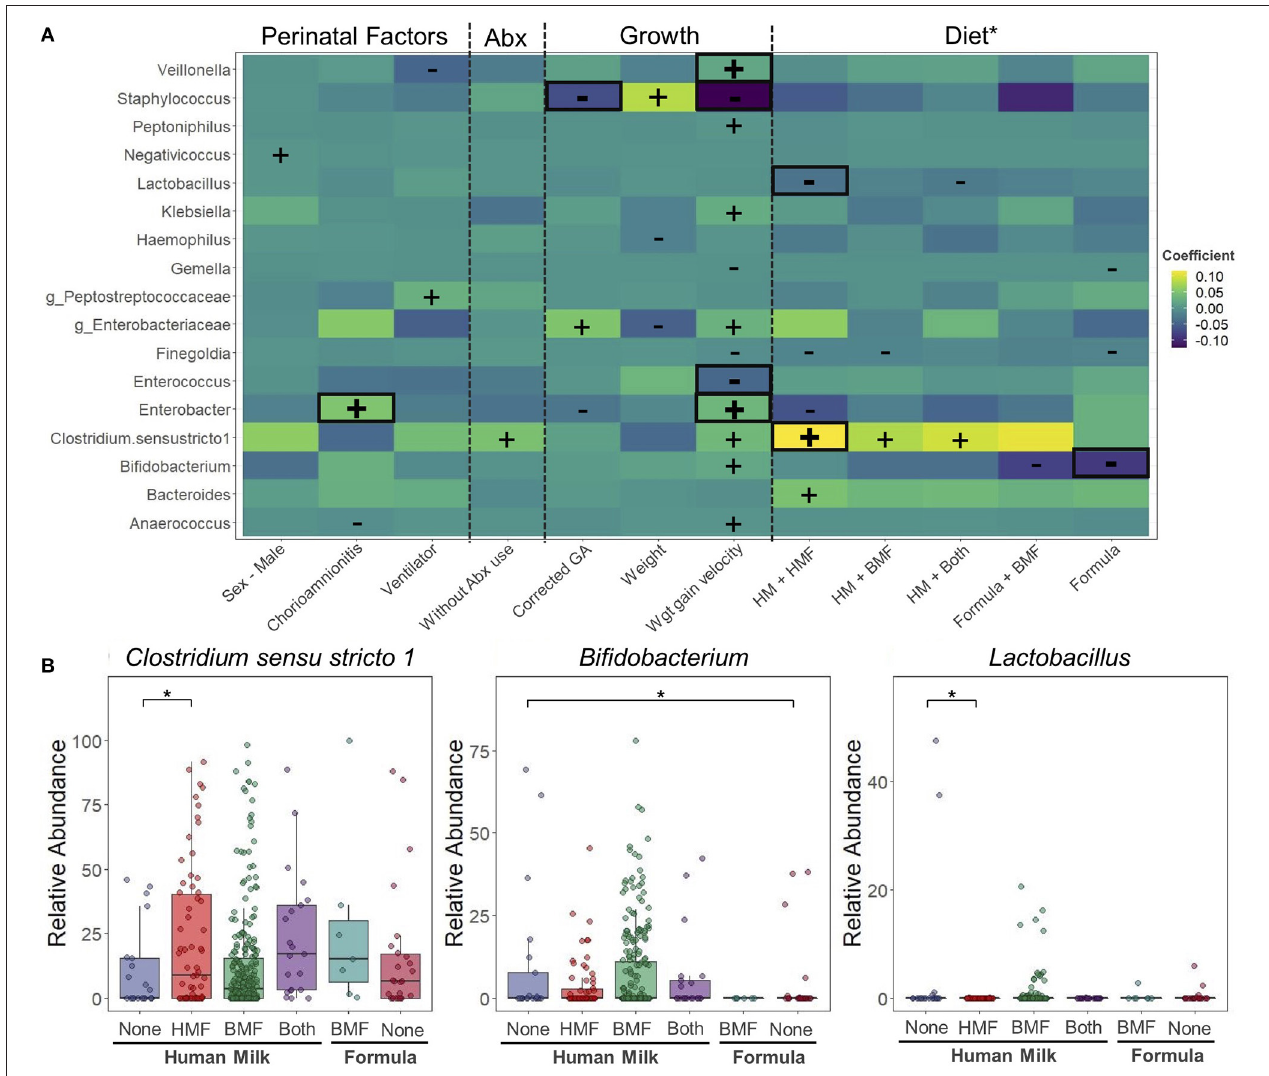
FIGURE 5 | Changes in taxonomic composition during hospitalization period at the neonatal intensive care unit. Taxonomical changes associated to different perinatal factors. (A) Heatmap of associations between bacterial genera and perinatal factors, use of antibiotics, growth and diet. Positive ( + ) and negative (–) signs denote significant associations ( p < 0.05). Highlighted in red are the associations that remained significant after false discovery rate adjustment ( q < 0.05). Differences calculated using Microbiome Multivariable Association Linear Models (MaASLin2). Model included infant sex, exposure to chorioamnionitis, use of mechanical ventilation, exposure to antibiotics, corrected GA, body weight, weight gain velocity, and type of milk and fortifier consumed. Infant was included as a random effect term. (B) Bacteria significantly affected by dietary factors. *HM without fortification as control group. Corrected GA: gestational age at birth + postnatal age. Abx, antibiotic; PROM, premature rupture of membranes; GA, gestational age; HM, human milk; HMF, human milk-based fortifier; BMF, bovine milk-based fortifier; Wgt,